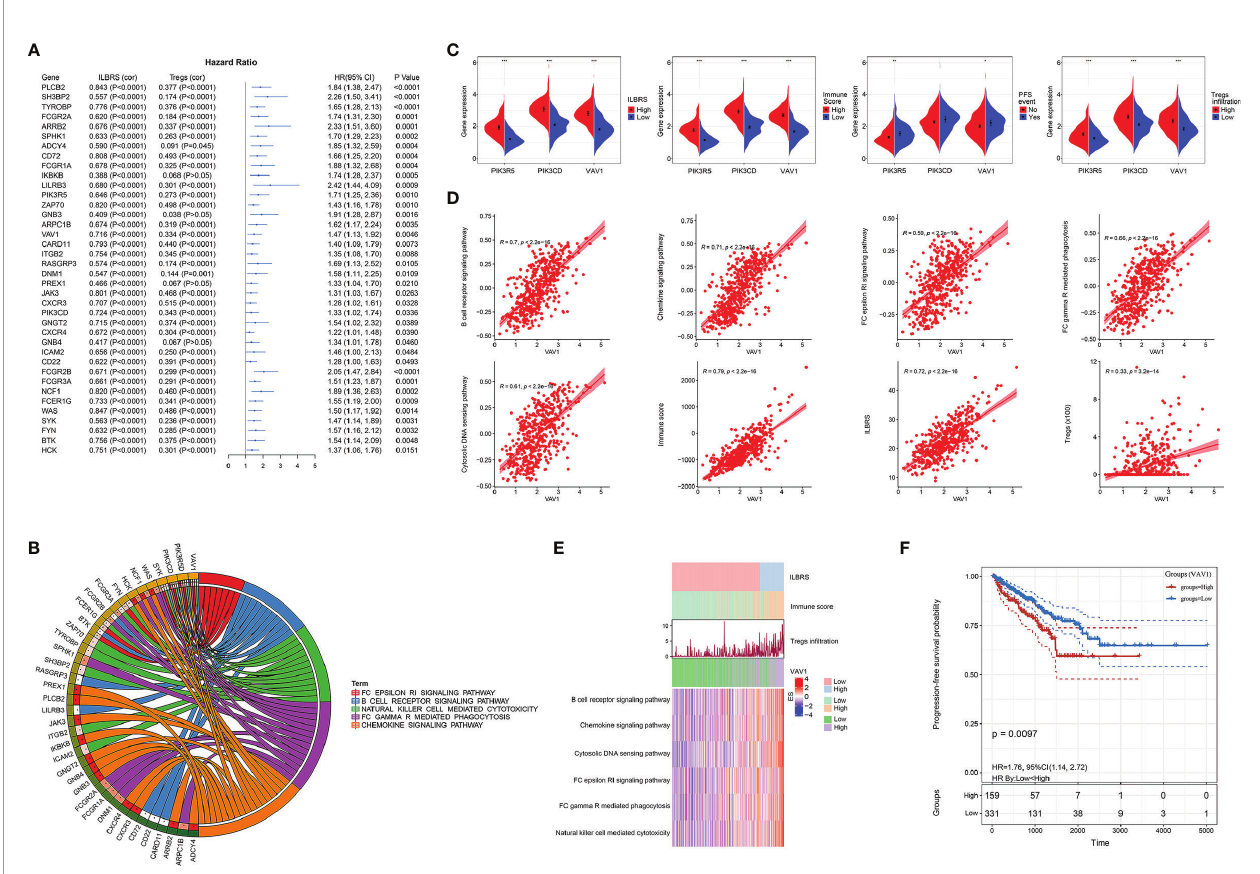
FIGURE 4 | Identi fi cation of VAV1 , an ILBRS-relevant predictor and therapy target for PFS of PCa patients. (A) Forest plot of the results of univariate Cox regression analyses of the core enrichment genes of the immune-relevant KEGG pathways. The square data markers indicate estimated hazard ratios (HR). The error bars represented 95% CIs. “ cor ” indicates the coef fi cient gained through Pearson correlation analysis. (B) The core enrichment genes are associated with PFS of PCa patients in immune-relevant KEGG pathways. (C) Different expressions of VAV1 , PIK3CD , and PIK3R5 between PCa patients with high and low ILBRS, Tregs in fi ltration, and immune score, and between PCa patients with and without PFS event. (D) Pearson correlation analyses of VAV1 with Tregs in fi ltration, ILBRS, immune score, and the immune-relevant KEGG pathways. (E) Heat map of the immune-relevant KEGG pathways. (F) Kaplan – Meier curves for the PCa tissues from patients with high and low expression of VAV1 in TCGA-PRAD data. * p < 0.05; ** p < 0.01; *** p <